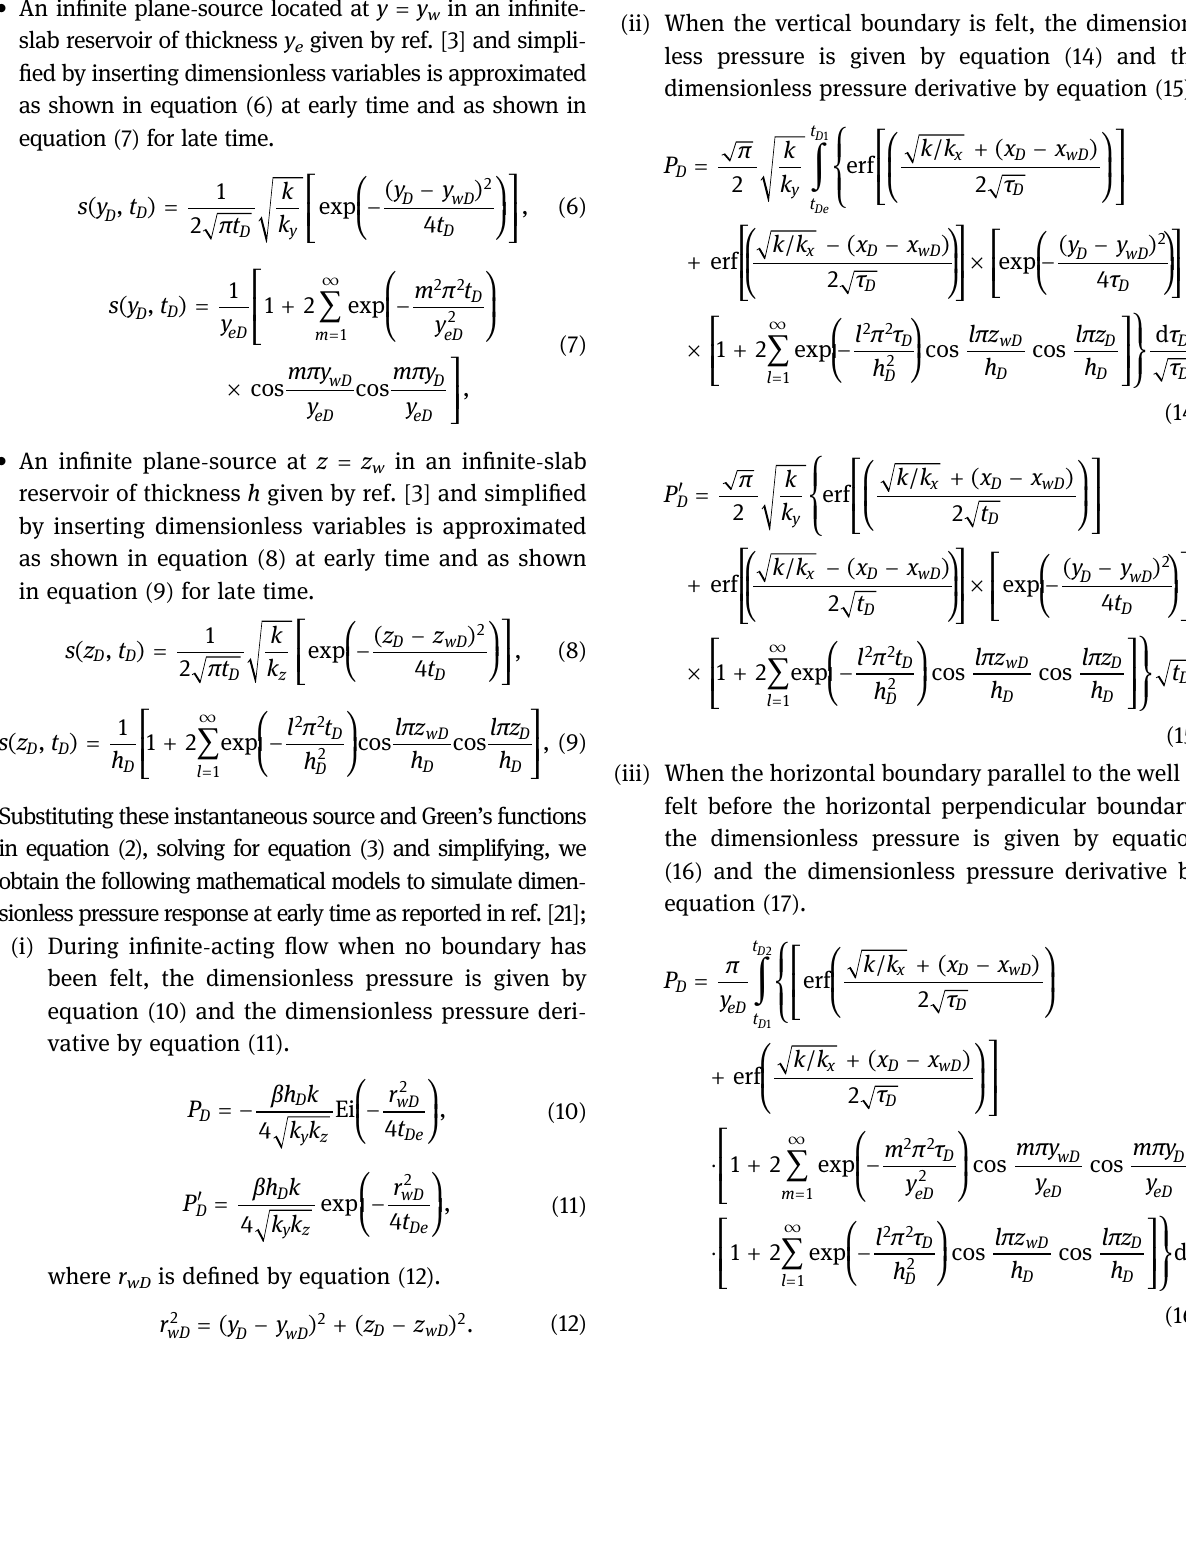
(cid:129) An in fi nite plane - source located at y = y